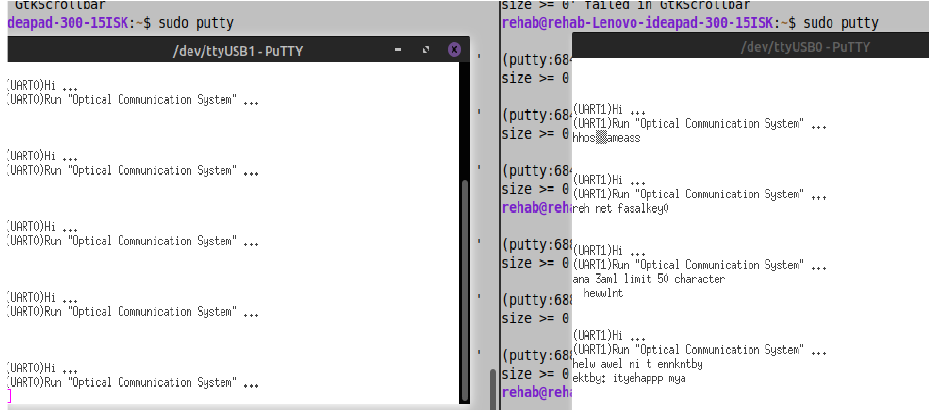
Figure 14. UART random text Communication between FPGA and PC.